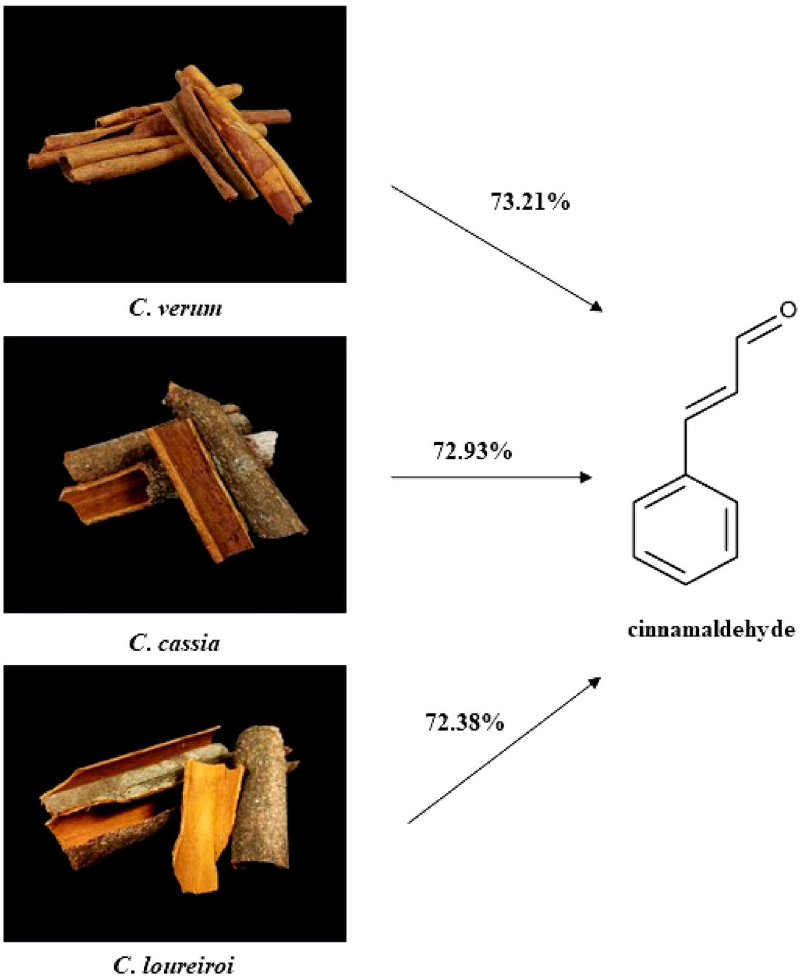
Figure 1. Barks of C . verum , C . cassia , and C . loureiroi ; % cinnamaldehyde of three Cinnamomum spp. EOs and chemical structure of